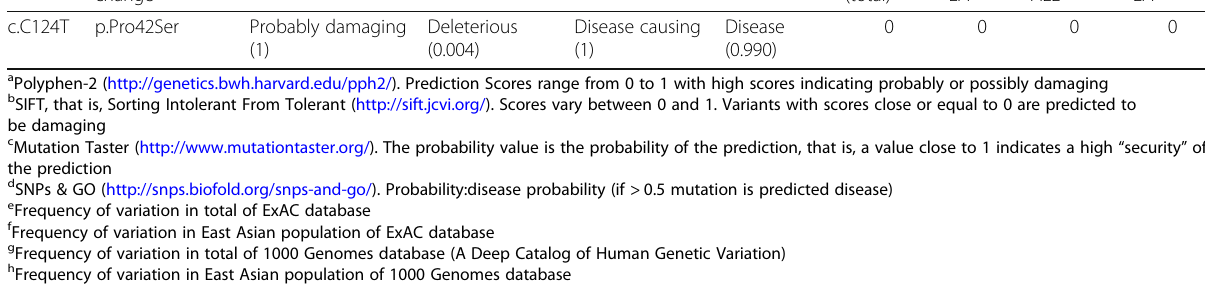
Table 1 In silico analysis of NOG mutations Mutation Amino acid change